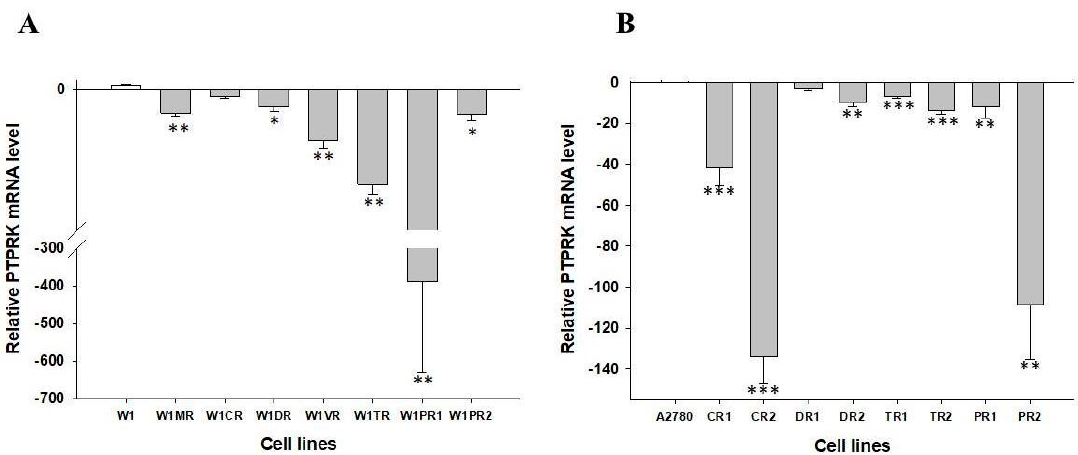
Figure 1. Expression analysis (Q-PCR) of the PTPRK gene in W1 and drug resistant cell lines ( A ) and A2780 and drug resistant cell lines ( B ). The figure presents the relative gene expression in the resistant cell lines (grey bars) with respect to that in the sensitive cell line (white bars), which was assigned a value of 1. The values were considered significant at * p < 0.05, ** p < 0.01 and *** p < 0.001.